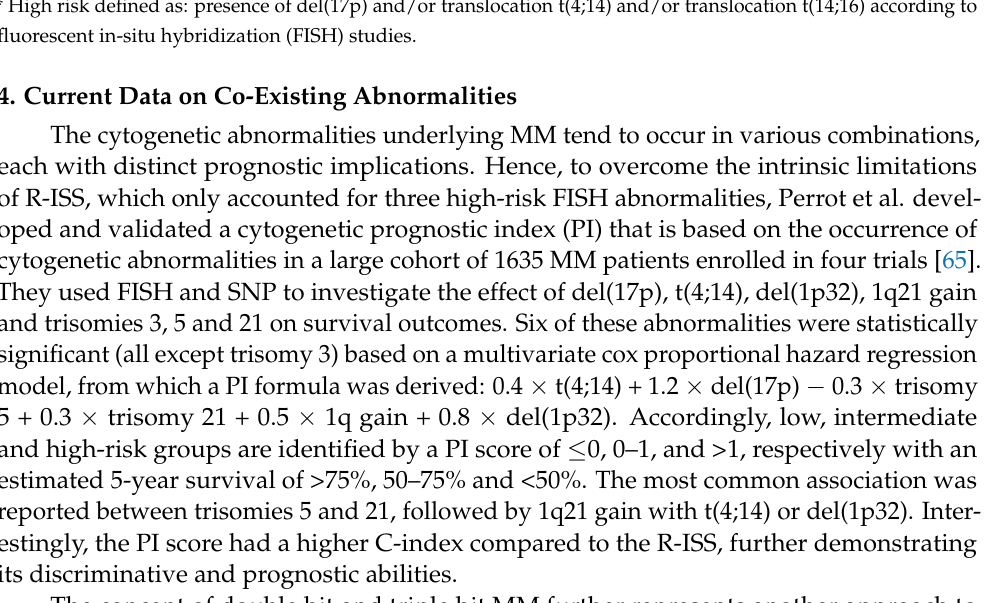
the following: -Elevated serum lactate